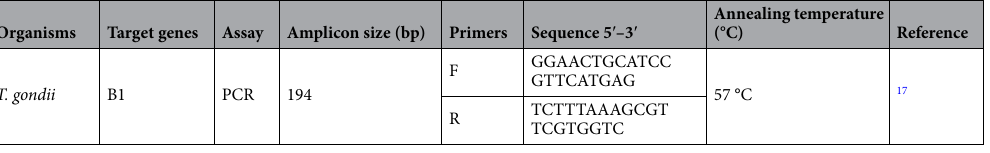
Table 1. Primer sequences for the amplification of T. gondii .